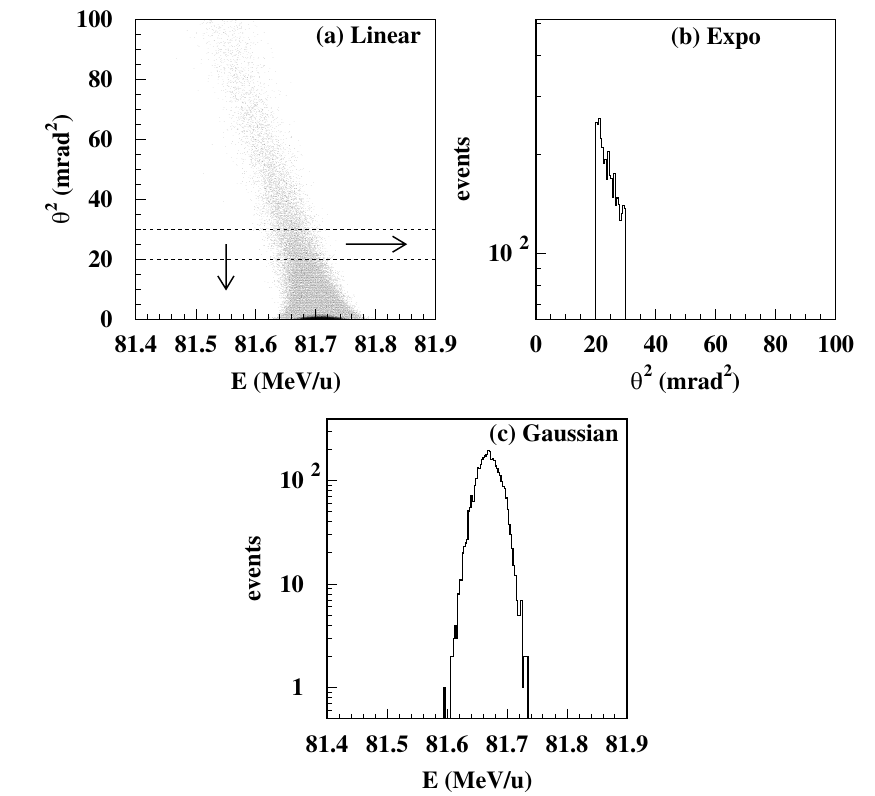
FIG. 2. Basis of the parameterization. (a) Linear correlation between the energy and angle squared, (b) projection on angle squared of the selected small interval on (a) showing an exponential distribution, and (c) projection on energy of the same angle interval suggesting a Gaussian distribution for every small angle